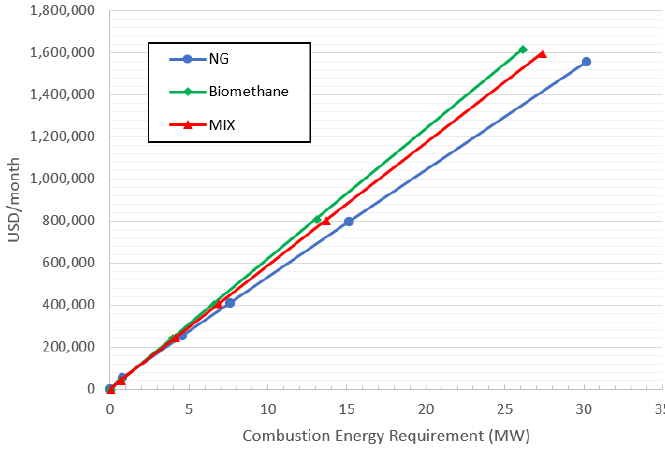
Figure 4. Costs of biomethane, mix and NG (Dec/2022).